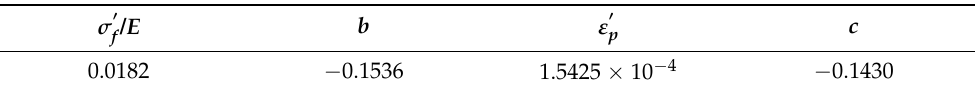
Table 3. Experimental conditions at 600 °C.